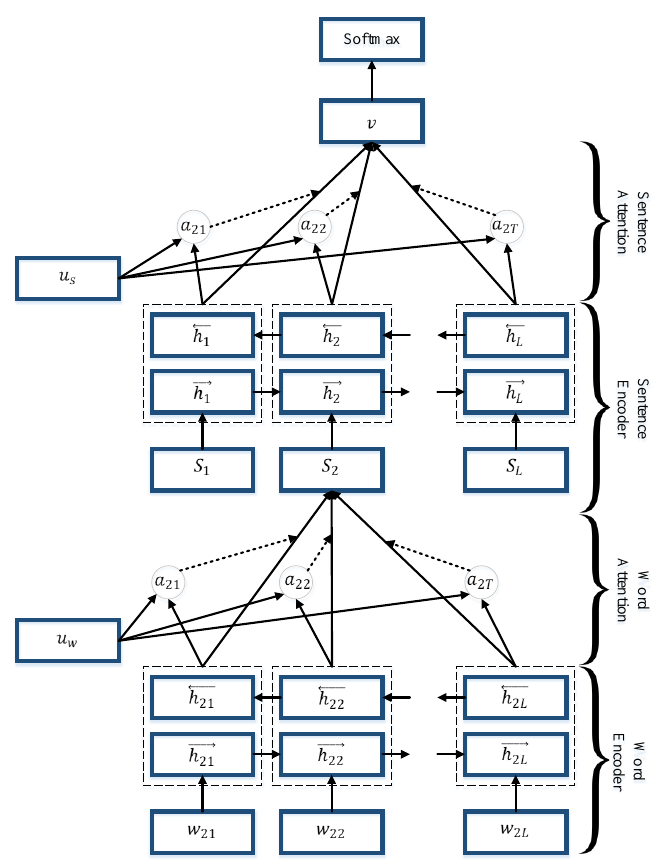
Figure 20. Hierarchical attention networks for document